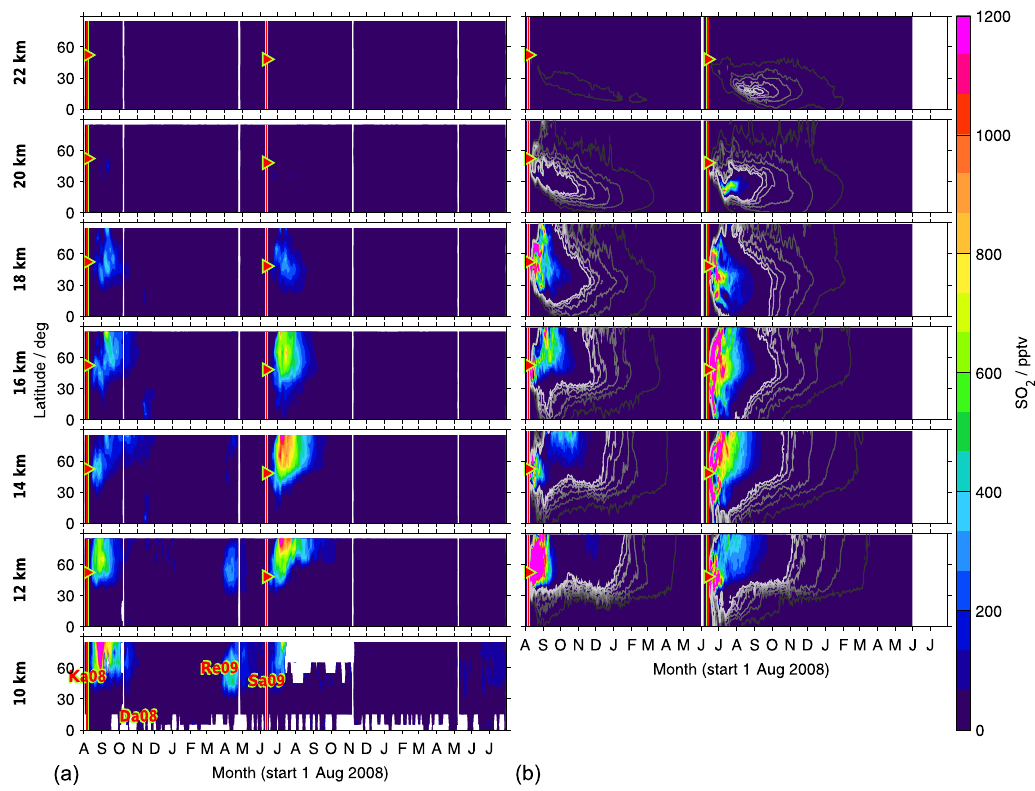
Figure 9. Time series of SO 2 from MIPAS measurements (a) and CTM simulations (b) . Shown are volume mixing ratios after the eruption of Kasatochi (7 August 2008) and Sarychev (12 June 2009), as zonal means for the Northern Hemisphere, at various altitudes (10 to 22km). For MIPAS 5d running means for 10 ◦ latitude bins are calculated, while for the CTM daily values are shown for ∼ 2.5 ◦ latitude bins. The colour code is restricted to 0–1200pptv. Values exceeding these limits are assigned the limiting value. Time and location of the eruptions of Kasatochi and Sarychev are indicated by red triangles. (a) Indicated are the eruptions of Kasatochi and Dalaffilla in 2008 and Redoubt and Sarychev in 2009, which were observed by MIPAS. (b) The two simulations are separated by a vertical white line (1 June 2009). Black to white contour lines denote 1, 5, 10, 20, 30, and 40pptv. Only Kasatochi and Sarychev are included in the